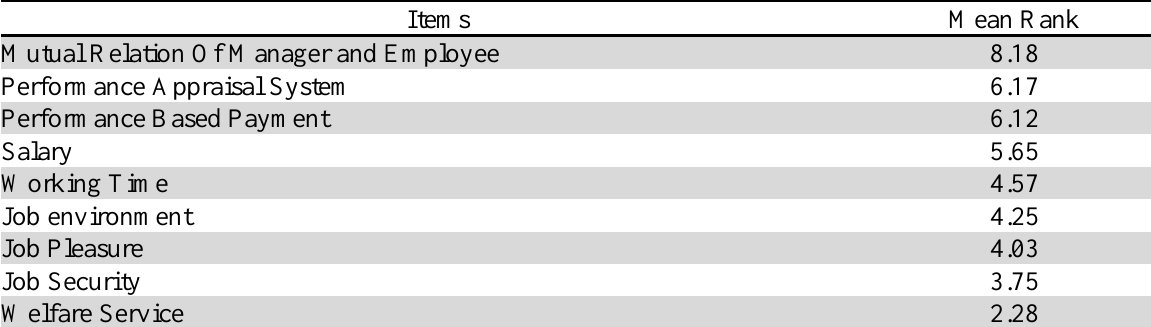
The results of Freedman